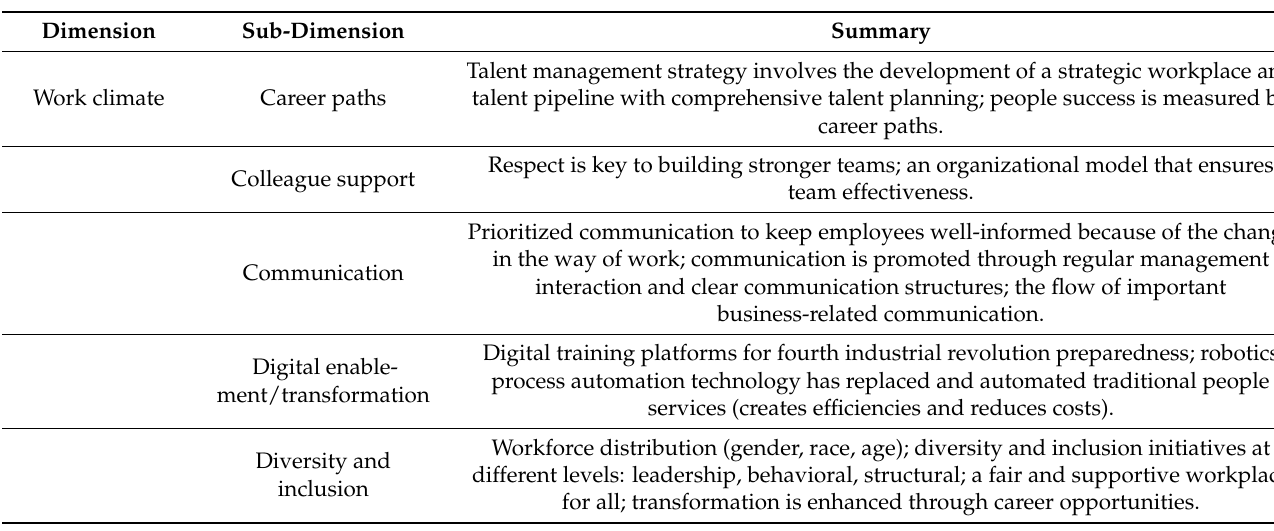
Table 5. Category 3: HC reporting